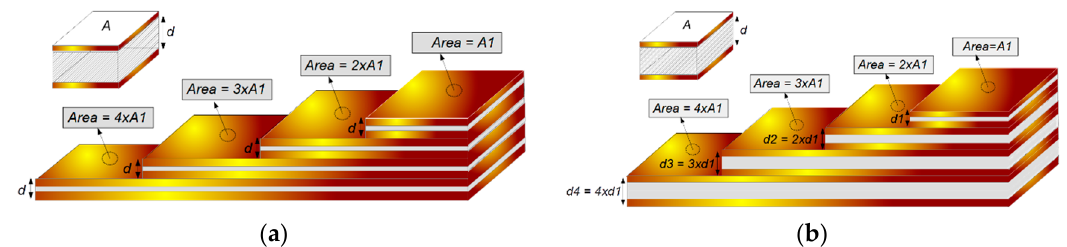
Figure 9. 3D view of the proposed package concept with the same distance d ( a ) and different distances d ( b ) [13].